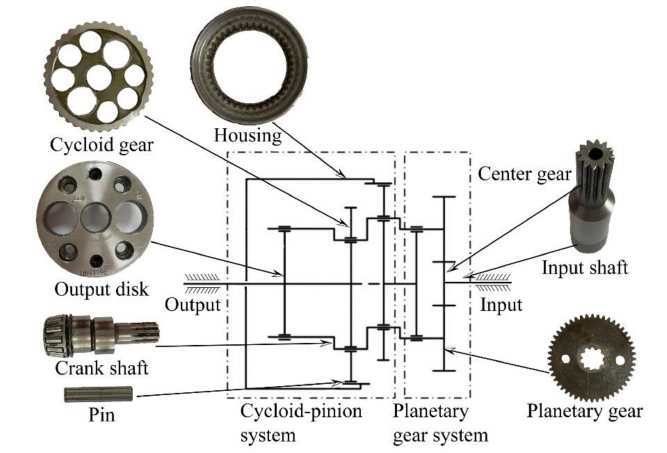
Figure 2. RV reducer